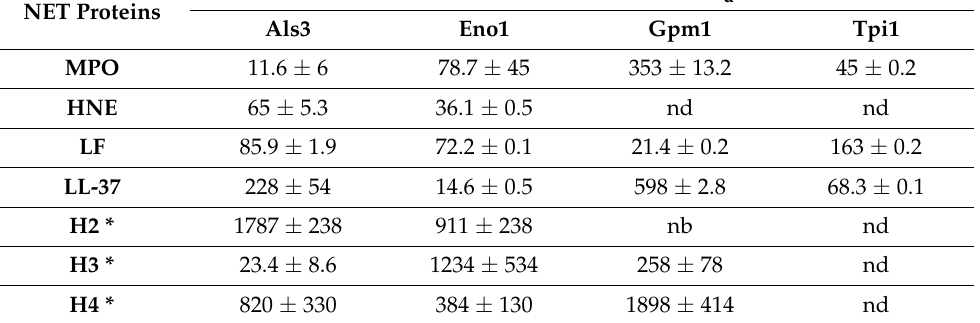
Table 1. Comparison of the binding parameters determined for the complexes formed between isolated C. albicans surface-exposed proteins and selected host proteins composing NET structures. The K d values were determined using the SPR technique applied in the BIACORE 3000 system, in which fungal proteins were immobilized on the surface of CM5 chips, reflecting the surface- immobilized nature of these proteins. The solutions of host proteins at the wide concentration range were allowed to make contact with the chip-immobilized fungal proteins. The association and dissociation processes were identified as was described in the legend to Figure 5. The data from three independent tests were analyzed by BIAevaluation software version 4.1 (GE Healthcare). For each dataset, the simultaneous fitting of the association and dissociation rate constants and the equilibrium constant was used with the 1:1 Langmuir binding model. (*) The binding parameters for all of the histones were determined by the ELISA-like method, in which the microplate-immobilized fungal protein was allowed to bind soluble fluorescent-labeled host proteins. The binding analysis was performed using GraphPad Prism software version 8.0 and a saturation one-site binding model (nd, not determined; nb, not bound). Cell Wall Proteins of C. albicans (K d (nM)) NET Proteins